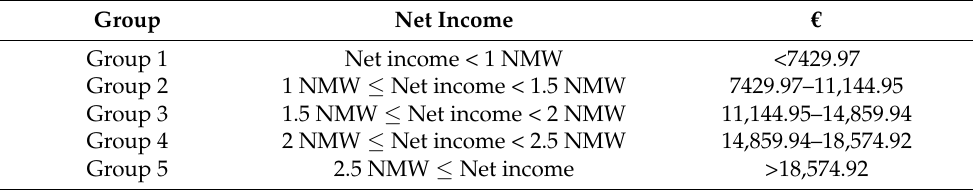
Table 1. Definition of groups.